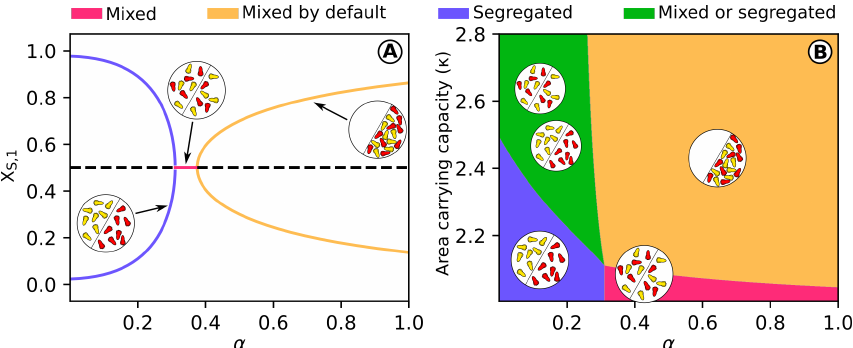
Figure 9. ( A ) Bifurcation diagram of the steady states of X S ,1 of model (3) as a function of parameter α for κ = 2.1; ( B ) state diagram of the type of existing solutions as a function of α and κ . Other parameter values are ρ =